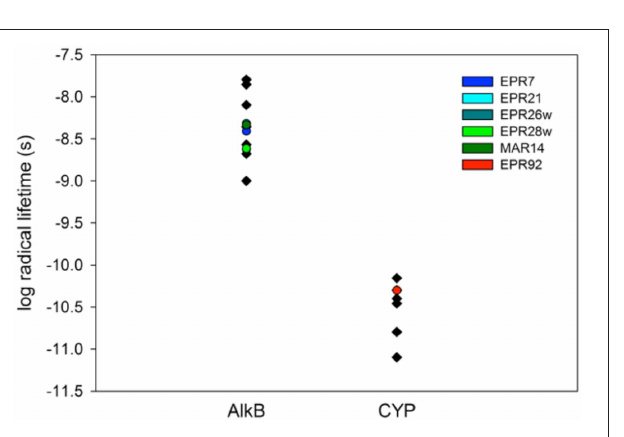
FIGURE 7 | Log of the radical lifetime for a series of AlkB and CYP-containing organisms. Data points given in black were previously described (Rozhkova-Novosad et al., 2007). Entries marked in color are from this work. EPR7, 21, 26w, 28w, and MAR14 clearly cluster with AlkB containing organisms while EPR92 displays a CYP-like radical